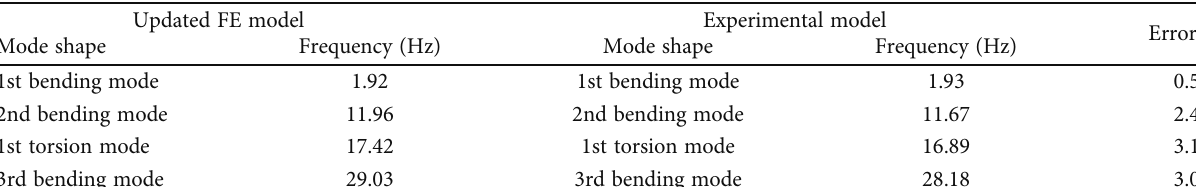
Table 2: Main wing natural frequencies and mode shapes.